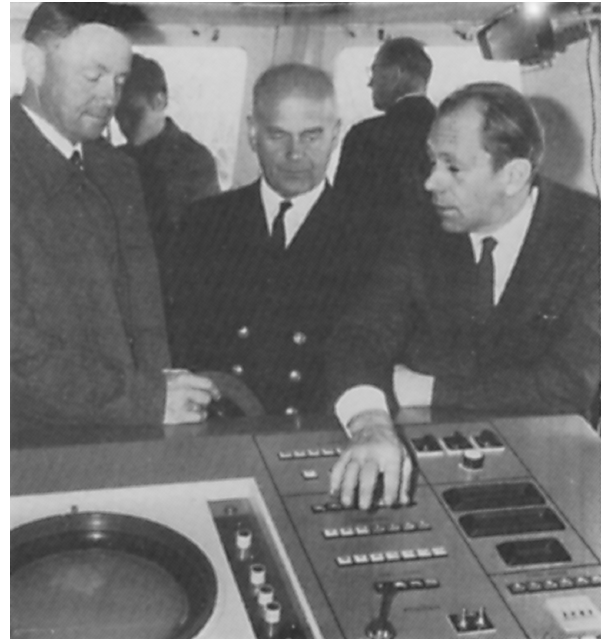
Figure 7: From the bridge of M/S Taimyr. Ibb Høivold from Norcontrol (right) in dicsussions